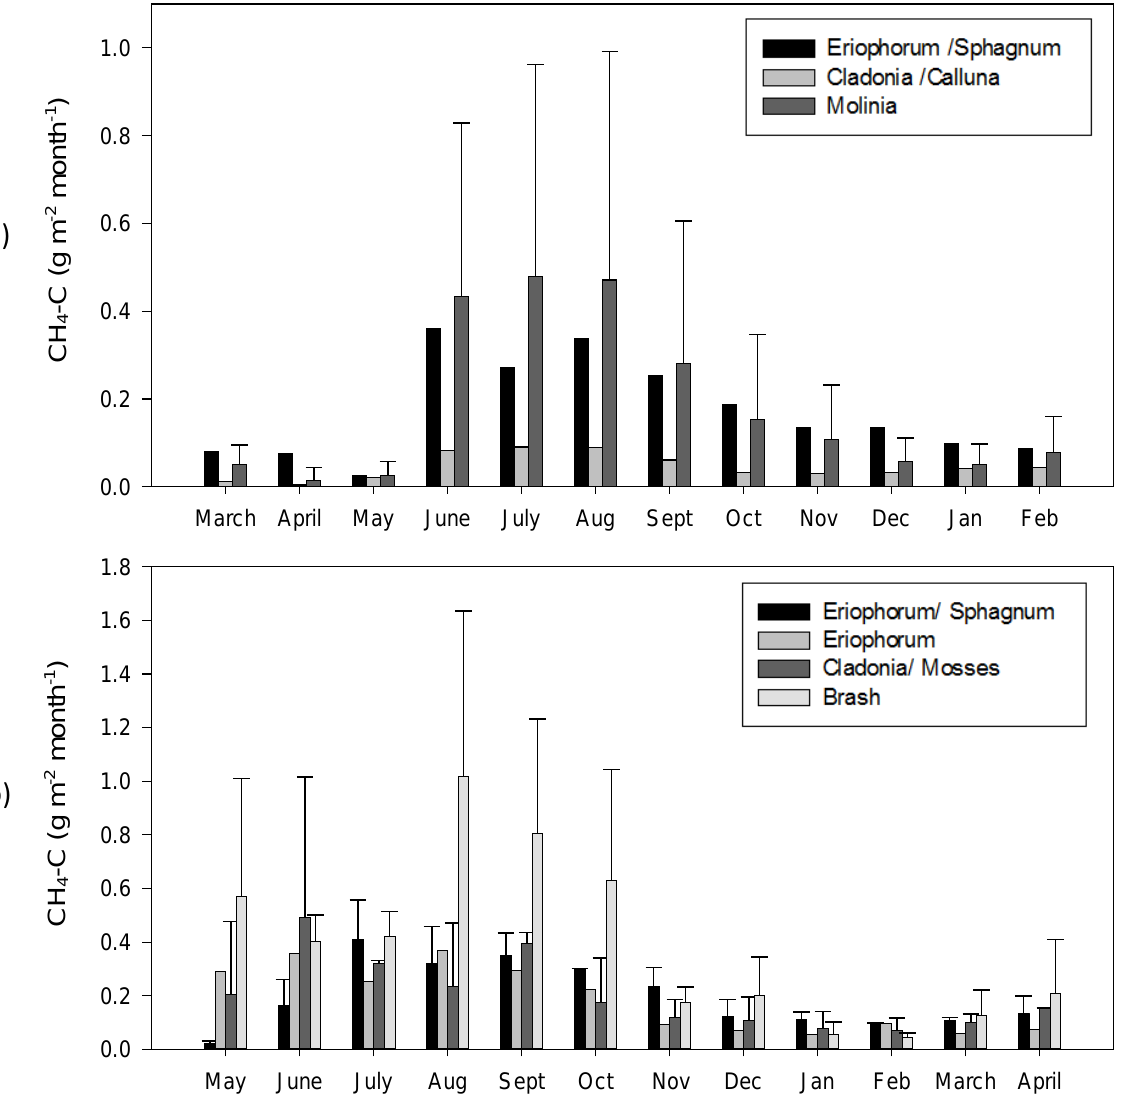
Figure 7. Interpolated monthly means of CH -C (g m -2 month -1 ) within the studied vegetation communities 4 at (a) Pollagoona and (b) Scohaboy. Error bars represent standard deviation on the interpolated means. Positive values indicate losses of CH to the 4